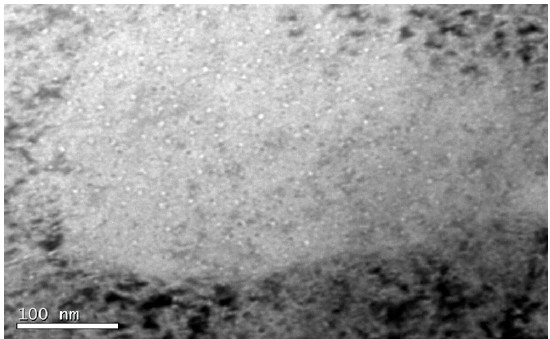
Figure 12. Cavities detected within the zone B of EU-ODS EUROFER (548–619 appm He) annealed at 450 °C for 100 h.